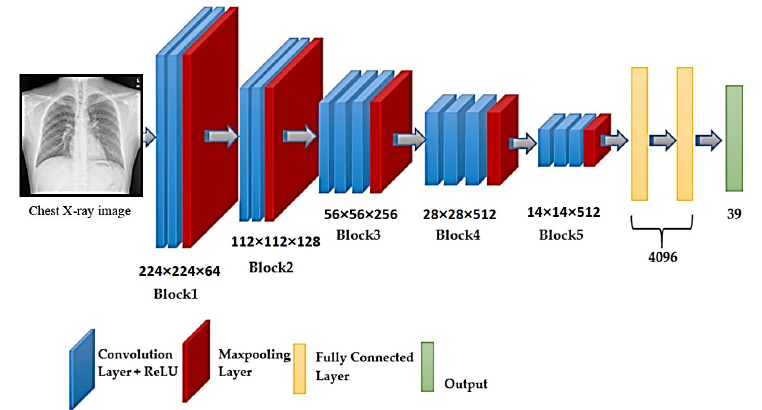
Figure 3. Schematic illustration of VGG16 architecture.